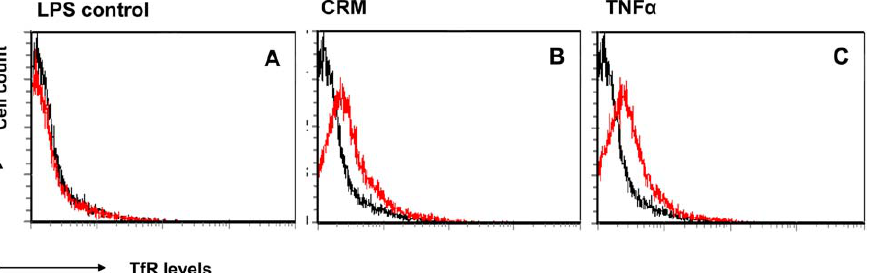
Figure 5. Proinflammatory cytokines increase TfR levels in Caco-2 cells. Flow cytometry analysis of Caco-2 cells following 48 h incubation with LPS (negative control, A), CRM (B), or TNF a